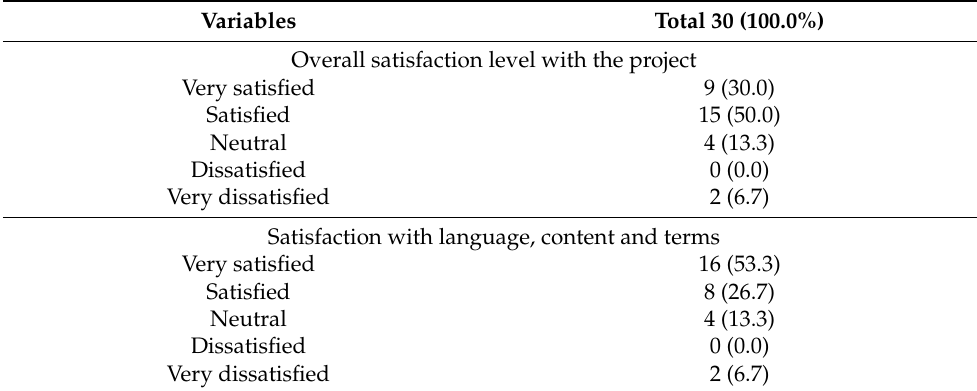
Table 5. Students’ perception of participation in the